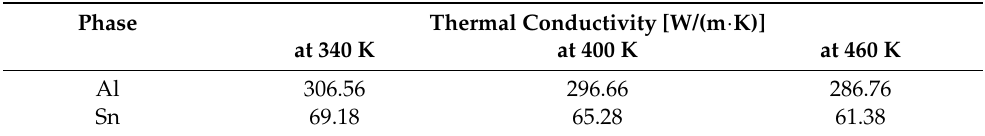
Table 1. Thermal conductivity values for Al and Sn at different temperatures inferred from the plot of experimental data provided in Reference [20]. Phase Thermal Conductivity [W/(m · K)] at 340 K at 400 K at 460 K Al 306.56 296.66 286.76 Sn 69.18 65.28